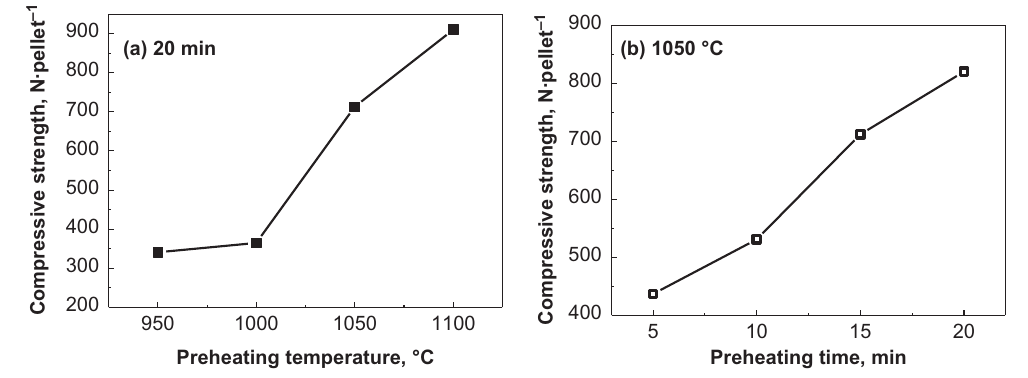
Figure 2: Effects of preheating on compressive strength.